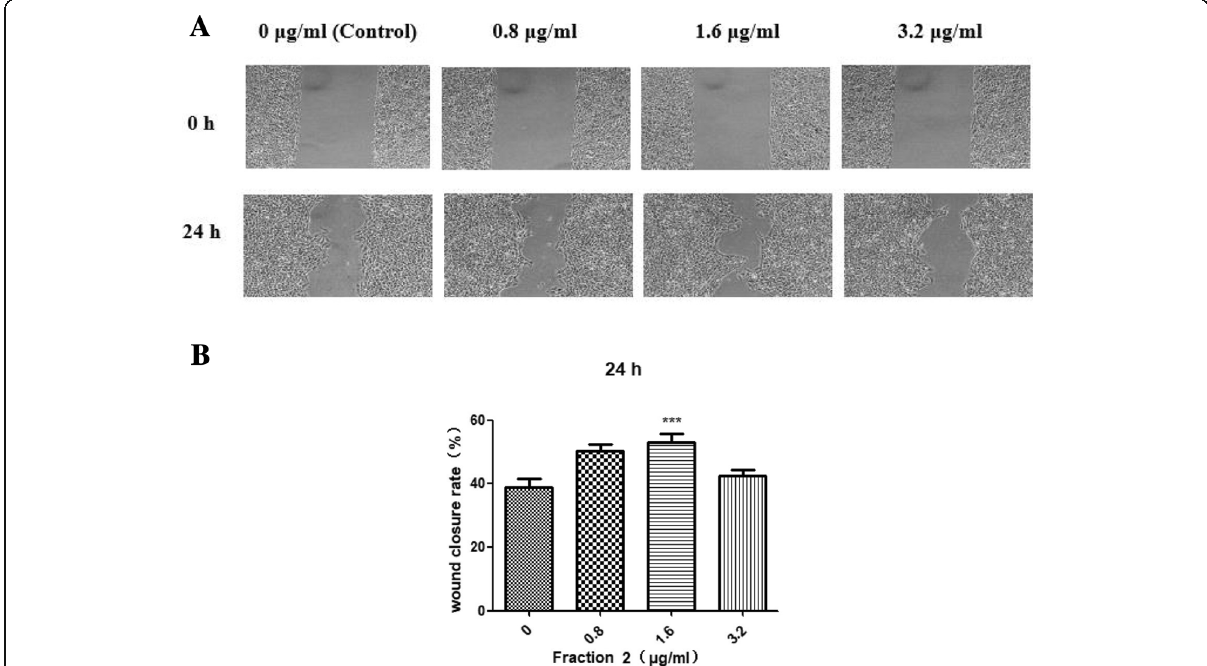
Fig. 3 Migratory effects of Fraction 2 on keratinocytes in the in vitro scratch wound assay. a Migration of HaCaT cells observed at ×100 magnification, 0 and 24h post-scratching. b Rate of wound healing, as calculated using Image J software. Wound closure rate %=(the scarification area at 0h – the scarification area at 24h) / the scarification area at 0h×100%. Three randomly captured scarification areas were measured in each well. Results are expressed as the mean±SEM of at least three determinations for each test from three independent experiments. Statistical significance of differences: *, p <0.05; **, p <0.01; ***, p <0.001 (* comparisons versus control